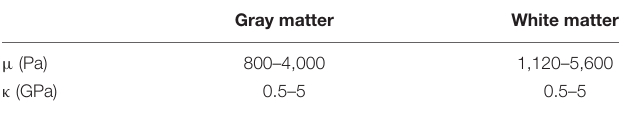
TABLE 3 | Parameter range for mechanical properties based on the literature (Xu et al., 2010; Budday et al.,